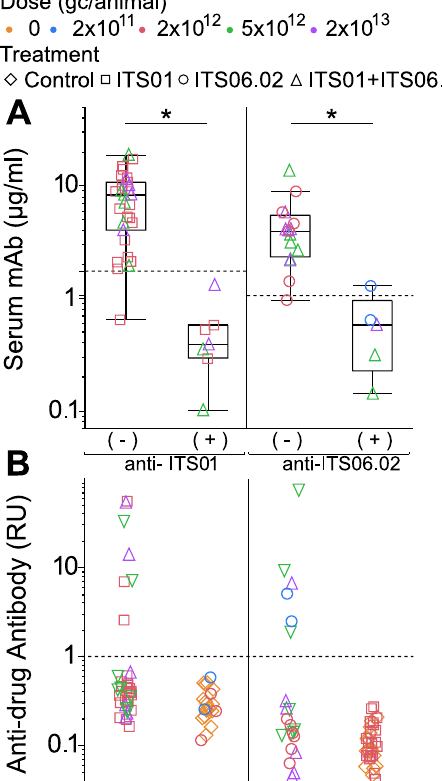
Fig 4. Infrequent ADA responses accompany loss of serum transgene mAb. (A) Serum mAb measurements in injected animals that did (+) or did not (-) develop anti-ITS01 (left) and/or anti-ITS06.02 (right). Hashed lines denote the limit of ITS01 or ITS06.02 positivity (2 SD above mean of negative control serum) at 1.3 μ g/ml, blue and 0.8 μ g/ml, red, respectively). Asterisks indicate statistical significance (p � 0.05). (B) Polyclonal serum ADA responses were quantified in relative μ g/ml equivalents to monoclonal control anti-idiotype antibodies. Hashed lines denote anti- ITS01 or anti-ITS06.02 threshold of positivity set at 1 RU. Dose and AAV treatments are coded by color (Control, low